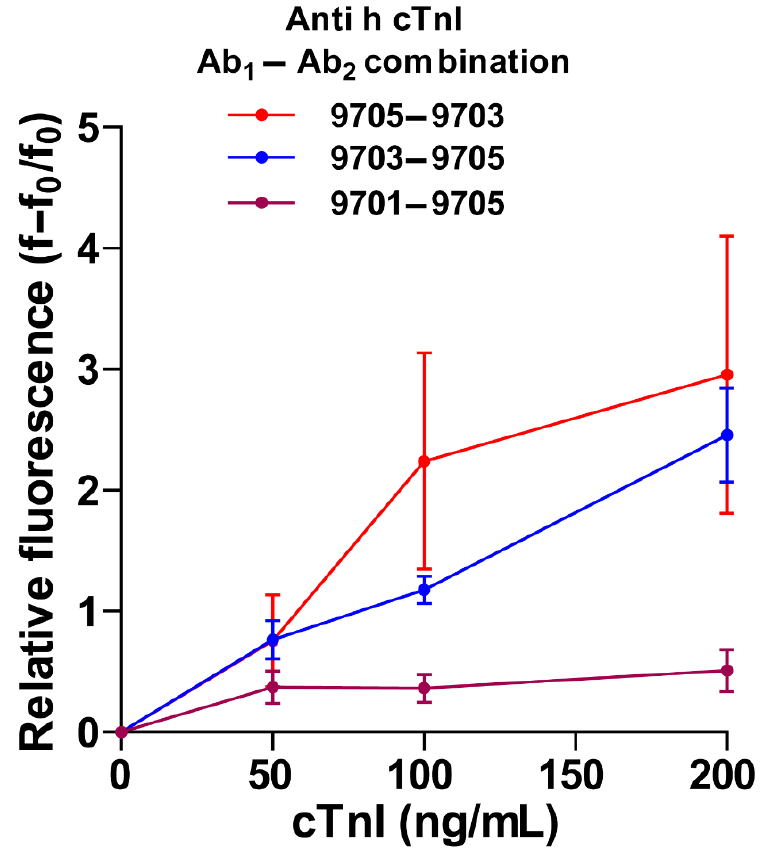
Figure 2. Effect of capture–detection antibody on the assay. The different plots correspond to the change in relative fluorescence over different cTnI levels exhibited by the assays with three different combinations of Ab 1 –Ab 2 . The assays were performed in 3 batches maintaining the coating concentration as 2 µ g/mL with cTnI levels of 0, 50, 100, and 200 ng/mL. The experiment used 2 µ g/mL of Streptavidin, 2 µ g/mL of Biotin–Ab 2 , and 1:100 diluted biotin calcein liposomes. The error bars show the standard deviation of values for the triplicate readings for three different assay experiments. (Two-way ANOVA test showed that there is statistically significant difference ( p < 0.05) between 9701–9705 assay and the other two assays ( p = 0.009 and p < 0.001), but there is statistically insignificant difference ( p = 0.446) between 9703–9705 and